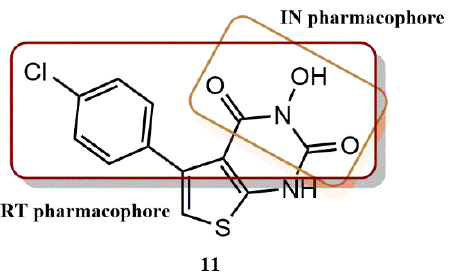
Figure 13. RT and IN pharmacophores of new active synthesized compounds 10a-h .